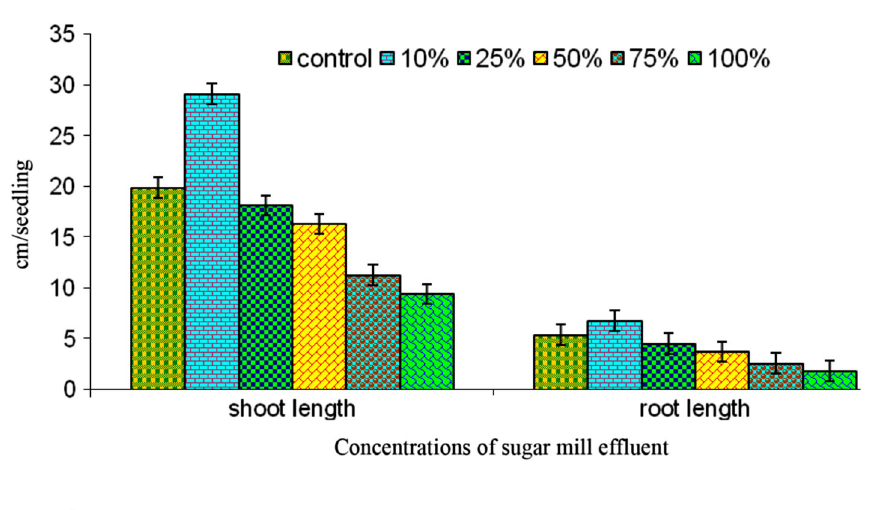
Fig. 3 Fresh weight and Dry weight of Tagetes erecta L. grown under different concentrations of sugar mill